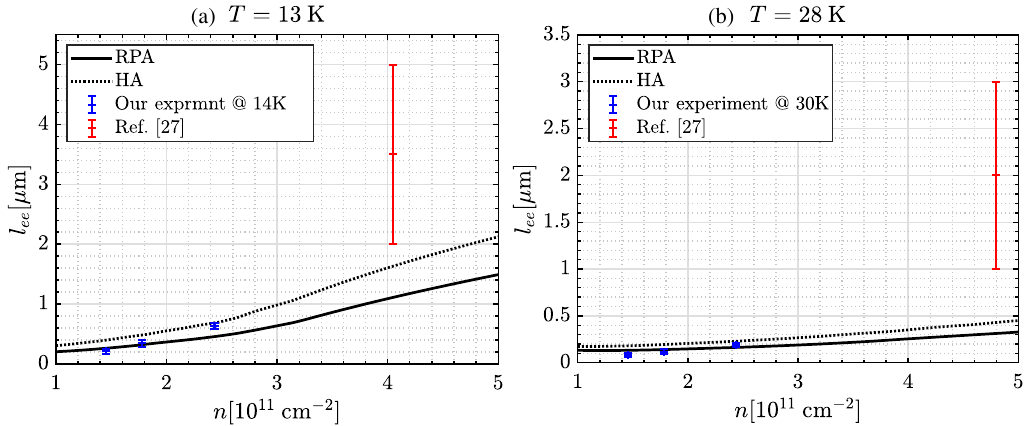
FIG. 11. Comparison of our l measurements as a function of electron number density n with that of the recent experiment by Gupta ee et al. [27] and the parameter-free calculations of l as described in Appendix F (a) at T ¼ 13 K (our data are obtained at T ¼ 14 K) and ee (b) T ¼ 28 K (our data are obtained at T ¼ 30